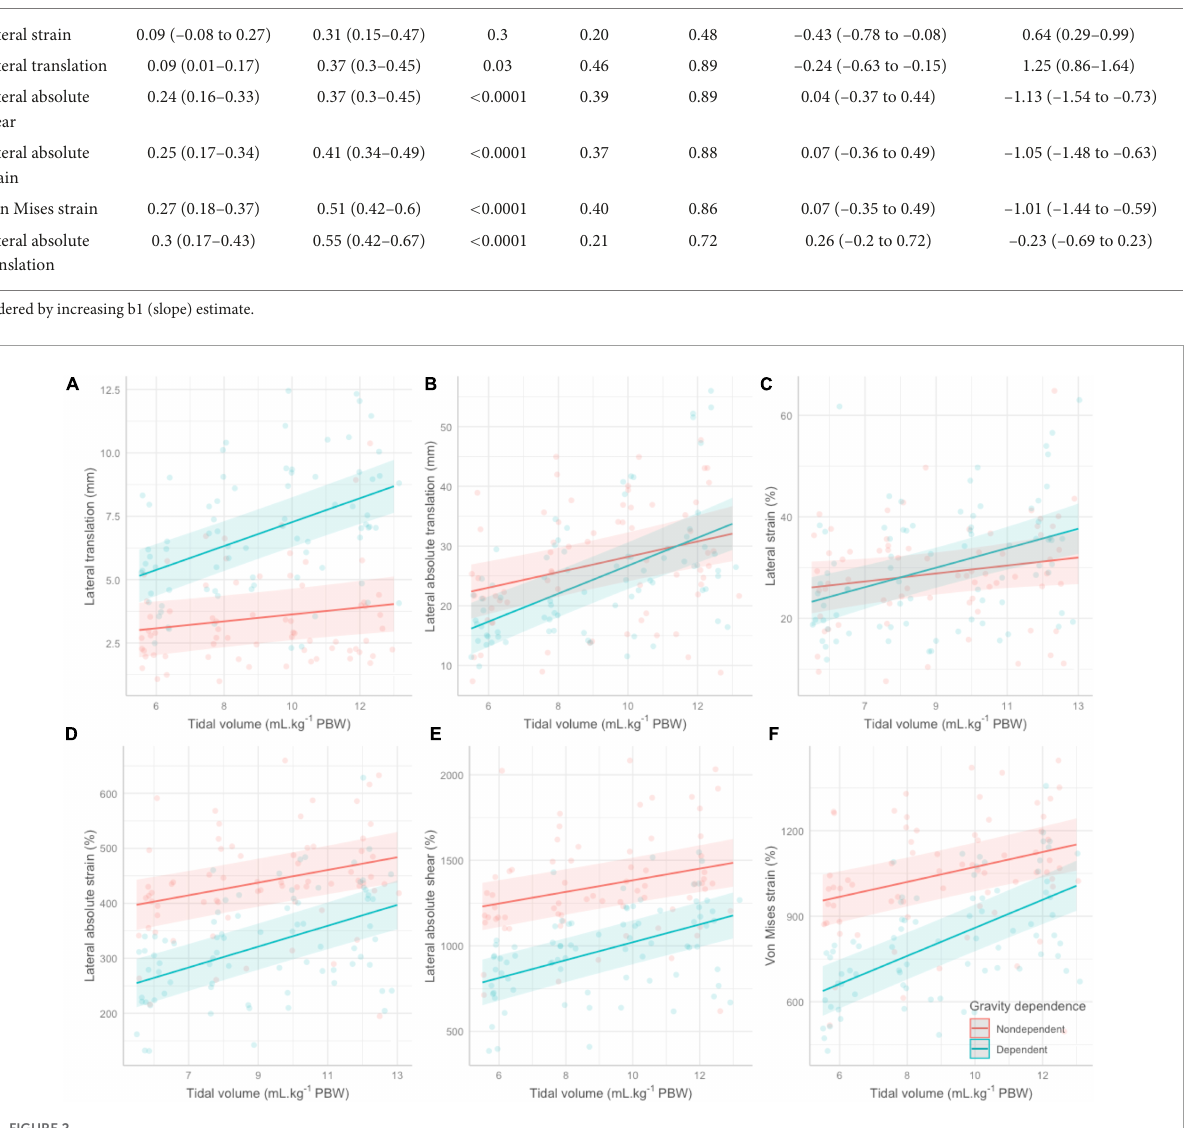
FIGURE2 Regression lines, 95% confidence bands and individual data points for all elastography parameters across the various tidal volumes stratified by gravity dependence. (A) Lateral translation. (B) Lateral absolute translation. (C) Lateral strain. (D) Lateral absolute strain. (E) Lateral absolute shear. (F) Von Mises strain. PBW, predicted body